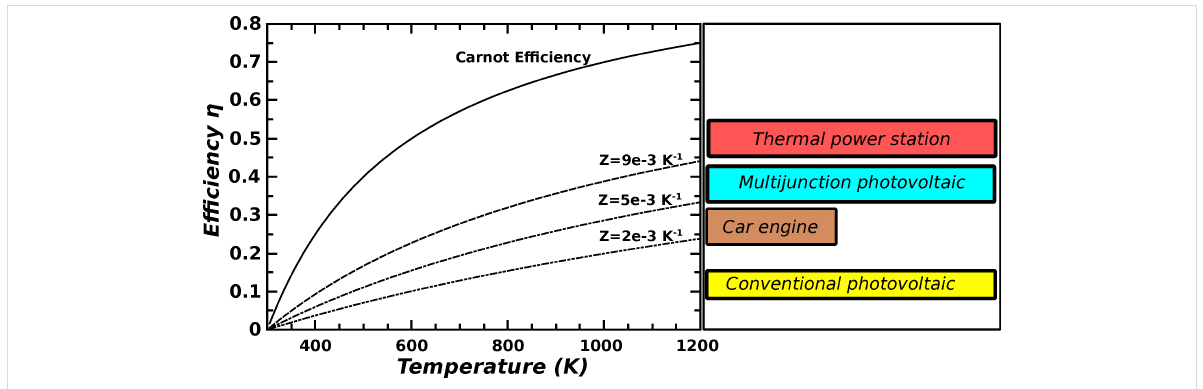
Figure 3: Efficiency of a thermoelectric generator for different values of the material-dependent parameter Z = S 2 σ / k t , as a function of the hot source temperature T H . The cold source temperature is T C = 300 K. The efficiency of conventional techniques for energy production is also reported for